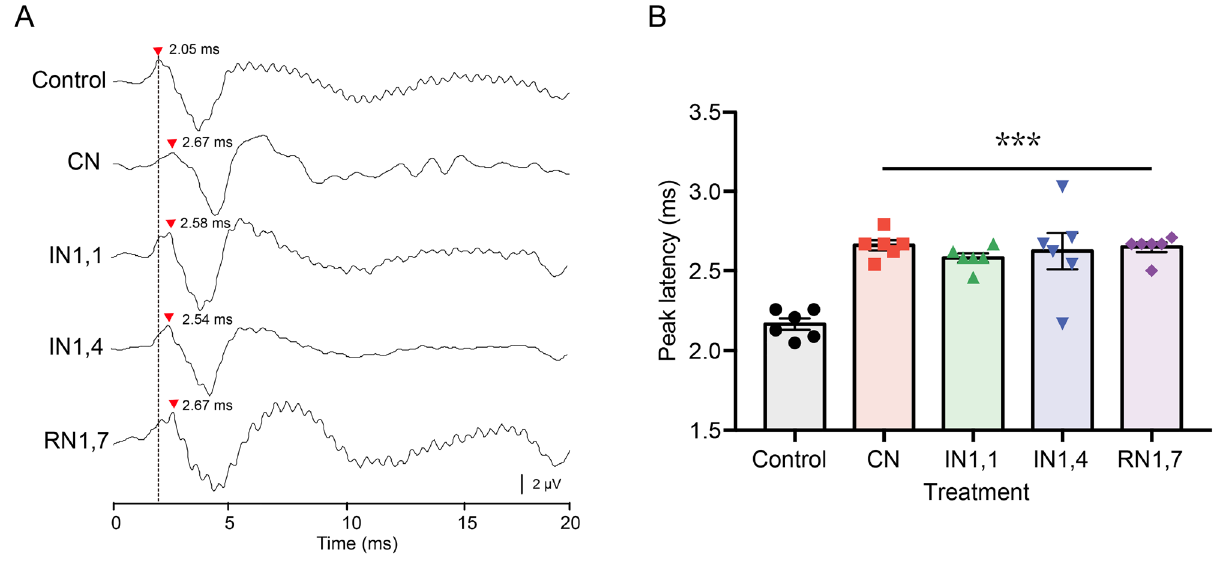
Figure 2. ( A ) Representative Auditory Evoked Potential (AEP) response curves of adult zebrafish under 1000 Hz stimuli (at 120 dB re 1 µPa) after different noise treatments. Arrowheads indicate the peak of each AEP and the corresponding latency with respect to the start of the stimulus. ( B ) Comparison of mean peak latencies ± Standard Error of the Mean (SEM) in response to 1000 Hz stimuli (at 120 dB re 1 µPa) after different noise treatments. Noise treatments caused a delay in response time (F 4,25 = 12.740, P < 0.0001) with significant differences between control and each noise treatment (***P < 0.001) (CN: continuous noise; IN1,1: intermittent noise with 1 s pulses and 1 s silent; IN1,4: intermittent noise with 1 s pulses and 4 s silent; RN1,7: intermitted random noise with 1 s pulses and 1–7 s silent intervals).